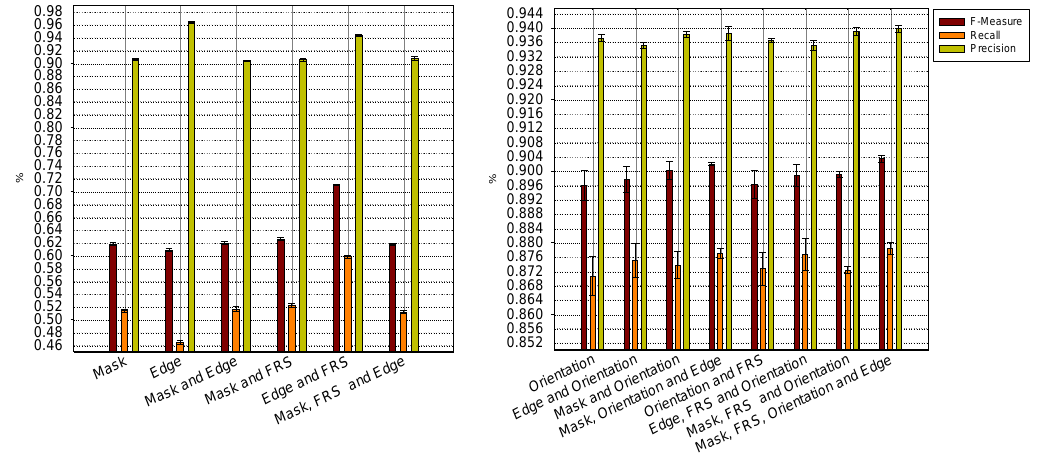
Figure 9. Evaluation of the proposed method with different features mixed ( left ) without orientation and ( right ) including the orientation feature.